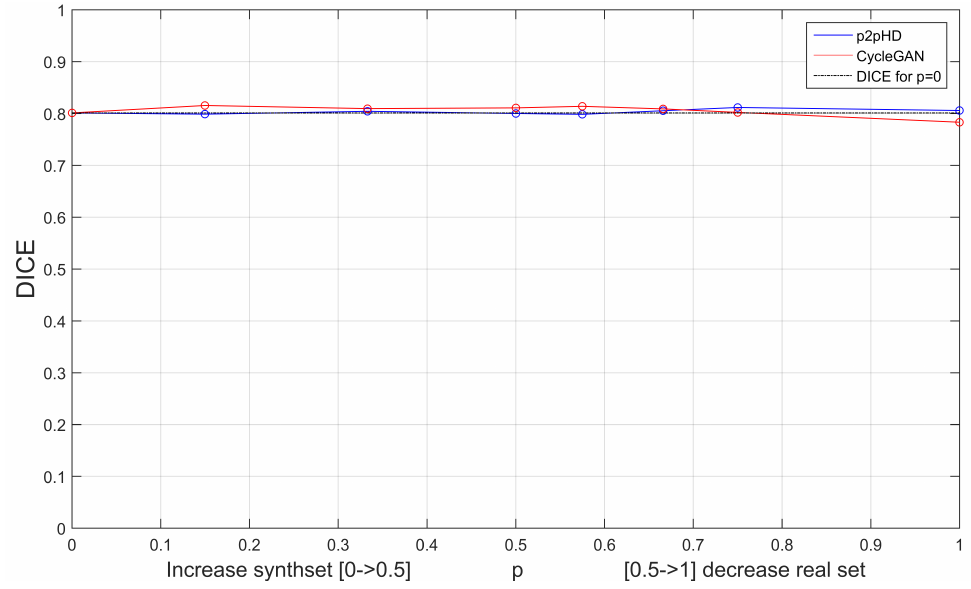
p = 0.5) and removal of real data ( p = 0.5 →